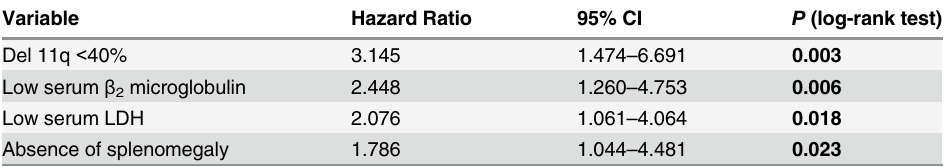
Table 3. Multivariate Cox regression analysis of overall survival in 11q- CLL patients with respect to the number of losses detected by FISH: < 40% (n = 51) or (cid:1) 40% (n = 146). *